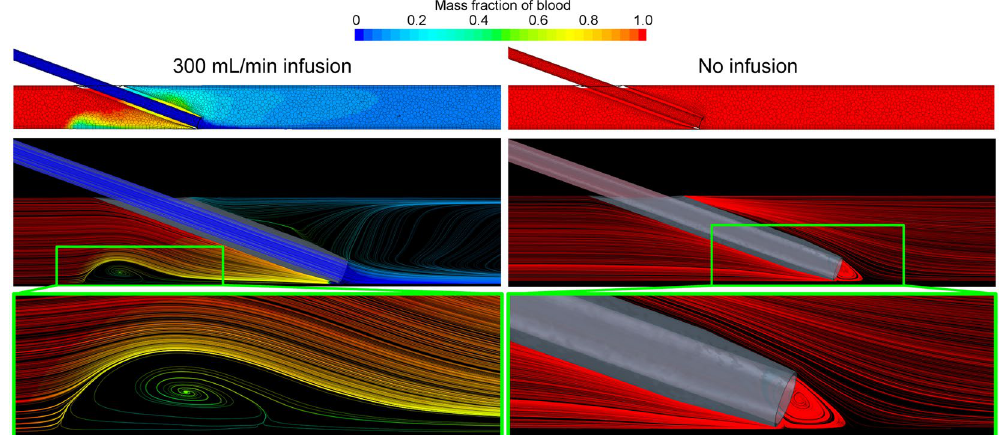
Figure 1. Resulting mass fraction of blood demonstrating the infusion of saline into the vein (left column) and the scenario without infusion (right column). Geometry shown is the 20 gauge (G), 20° insertion angle, positioned at the vessel edge. Only part of the geometry is shown and the images show a plane central through the catheter-vein geometry. The color bar refers to both the contours in the top row and the streamlines shown throughout. At this infusion rate (300 mL/min) the vein is practically cleared of blood and an area of recirculation (highlighted) is observed proximal to the catheter tip. In this zone the ratio of blood to saline is approximately 50:50. In the presence of the catheter, but without saline infusion, a region of recirculating blood (highlighted) is seen at the tip of the